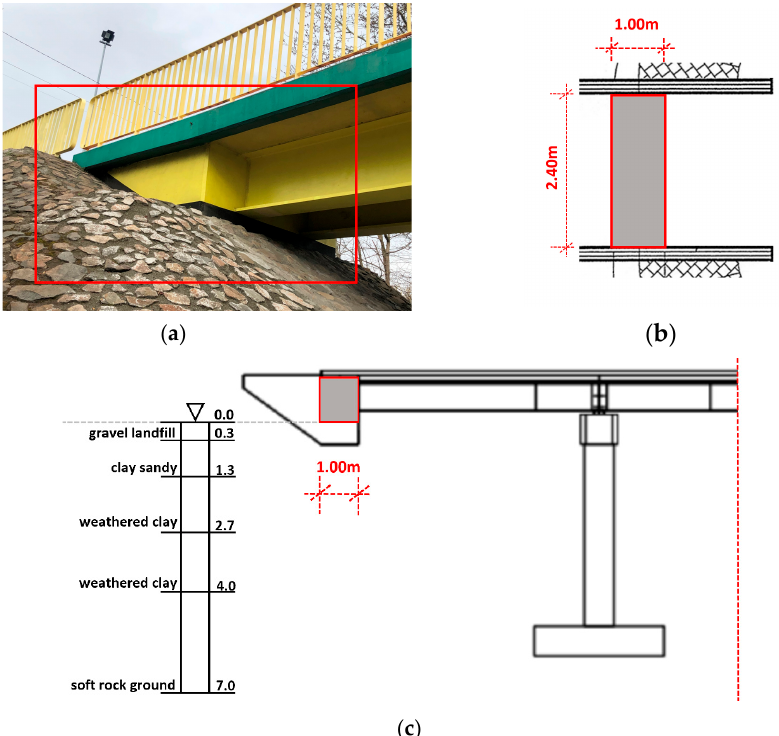
Figure 4. The steel-concrete composite footbridge: side view ( a ) and horizontal projection ( b ) of the overhang with the DSSI zone marked; ( c ) subsoil geotechnical profile from field test.